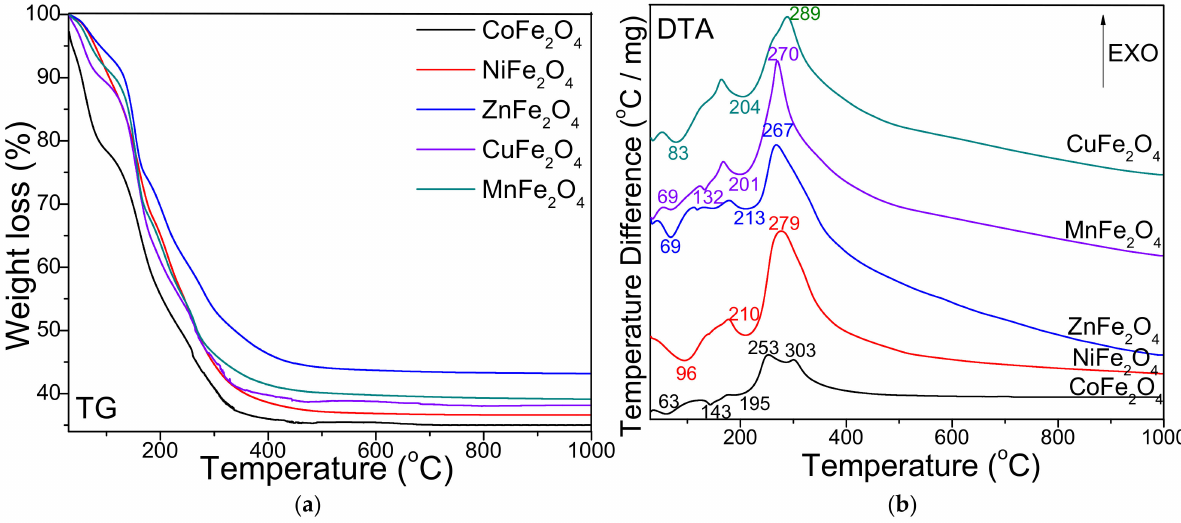
Figure 1. Thermogravimetric (TG) ( a ) and differential thermal analysis (DTA) ( b ) diagrams for MFe 2 O 4 (M = Co, Ni, Zn, Cu,